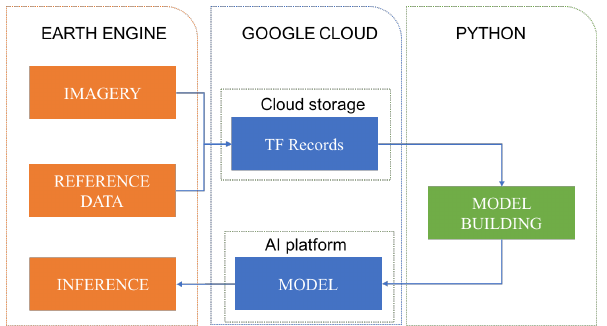
Figure 3. Workflow including the core of the proposed system illustrating the choice for cloud repository and